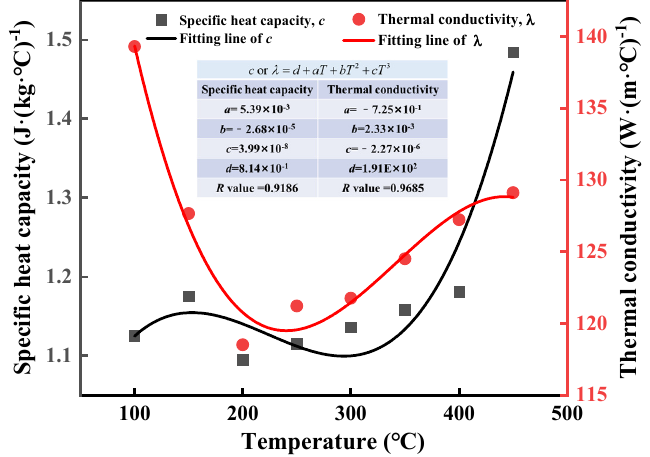
Figure 6. Specific heat capacity and thermal conductivity of AZ31B alloy under different temperatures.